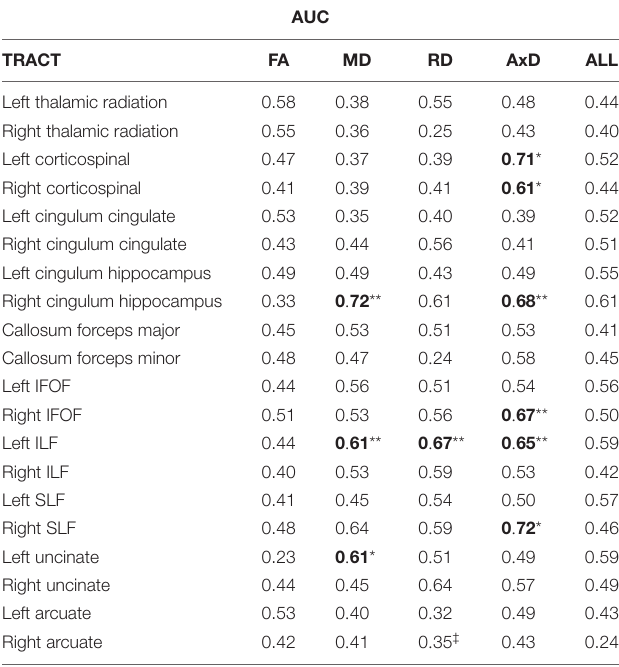
TABLE 3 | SVM classifier areas under curves (AUCs) from single tract